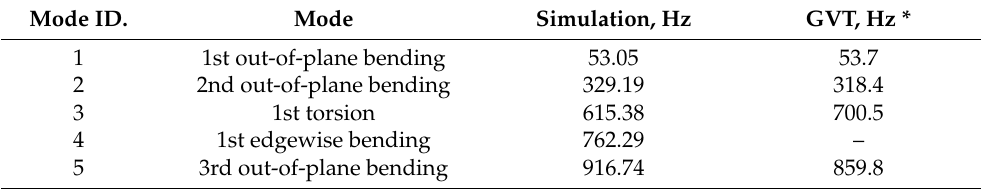
Table 6. Lower natural frequencies of the flutter wing with respect to bending and torsional modes. Mode